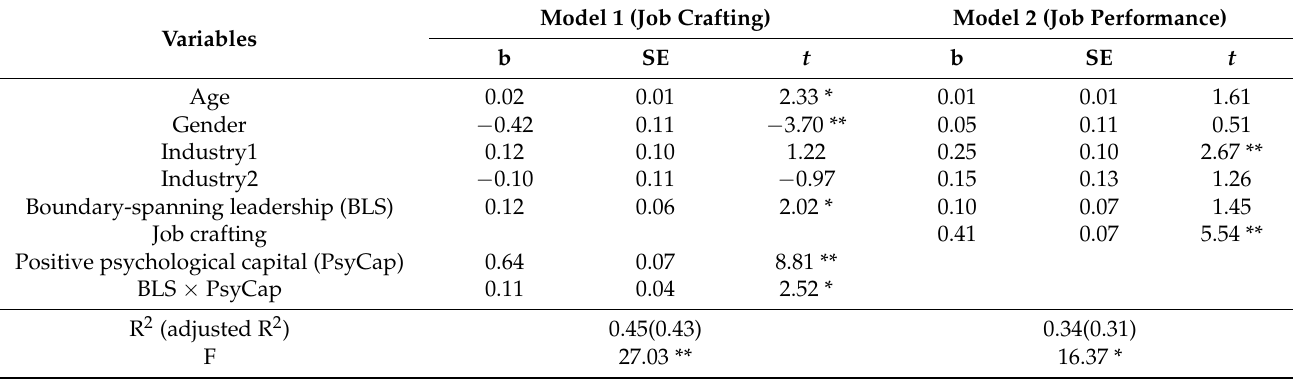
Table 3. Regression estimates for job crafting and job performance.